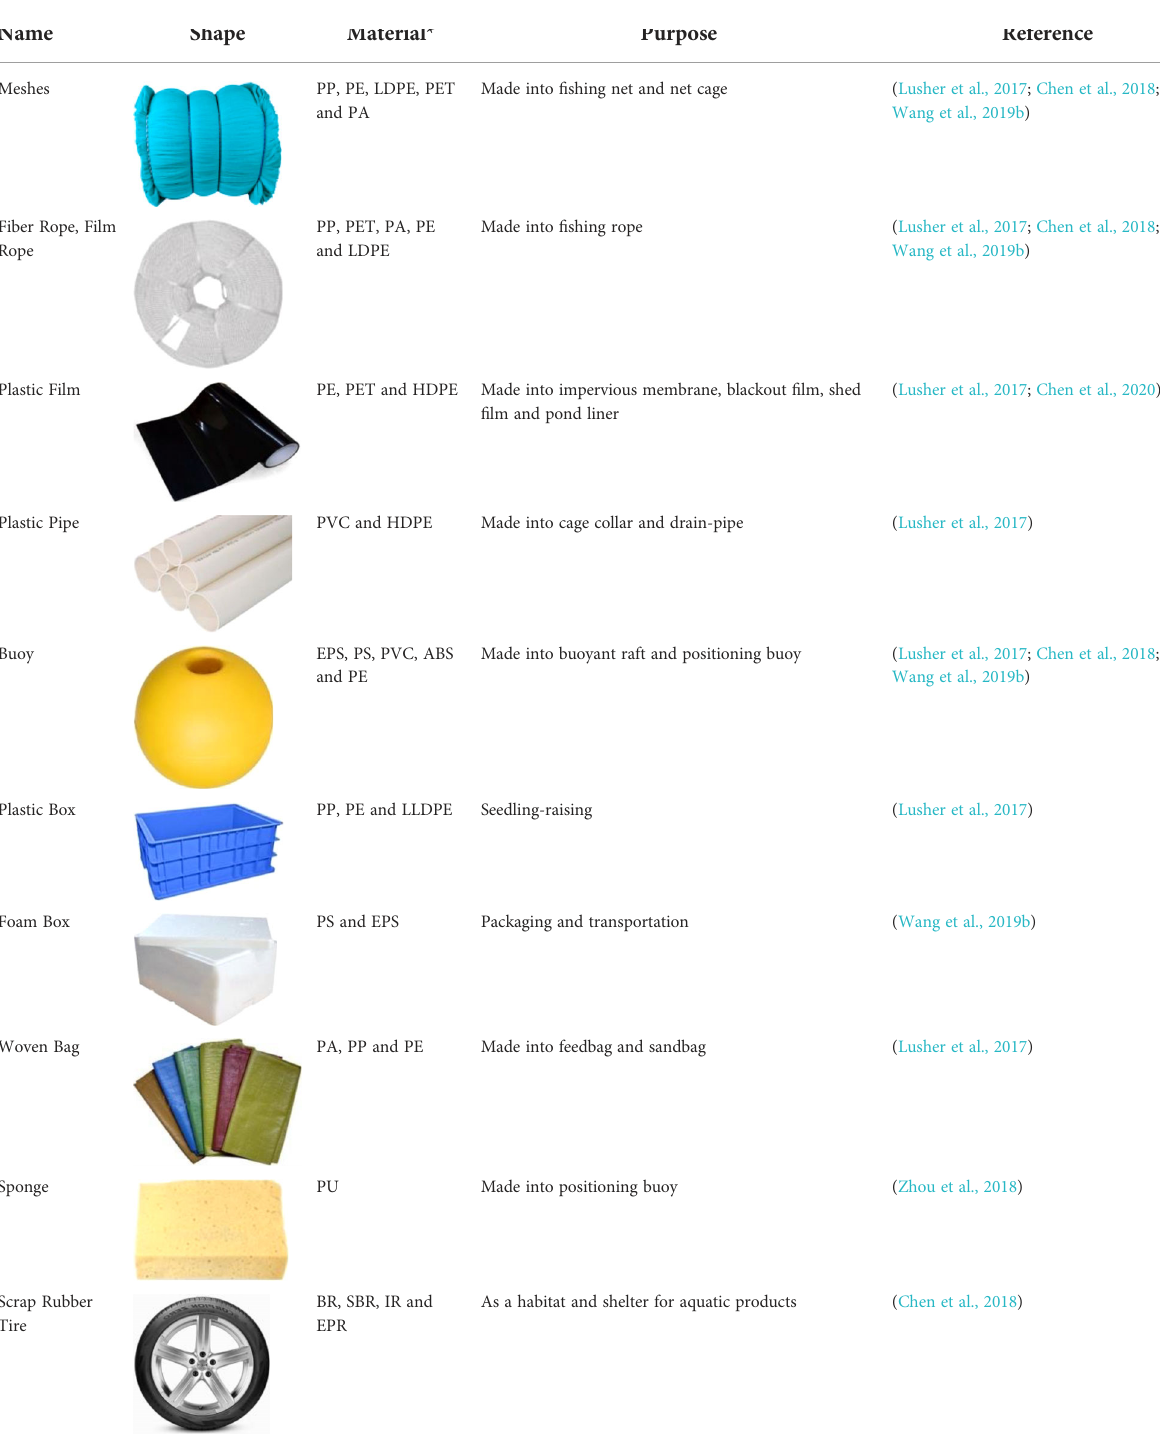
TABLE 1 Names, shapes, materials and purposes of common plastic equipment used in